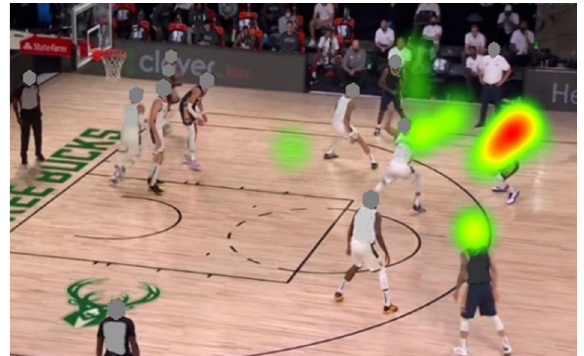
Figure 11. Heat map for